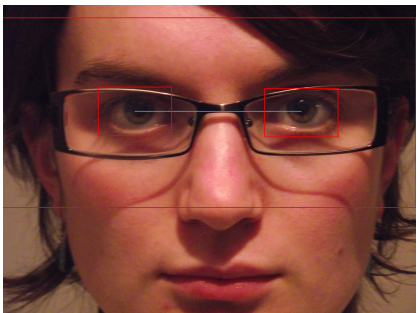
Figure 7. Eyeglasses region of interest (ROI). The detected position of the eyes are marked with red rectangles. The approximated interpupillary distance is marked with a blue line, and the eyeglasses search area is delimited by a red